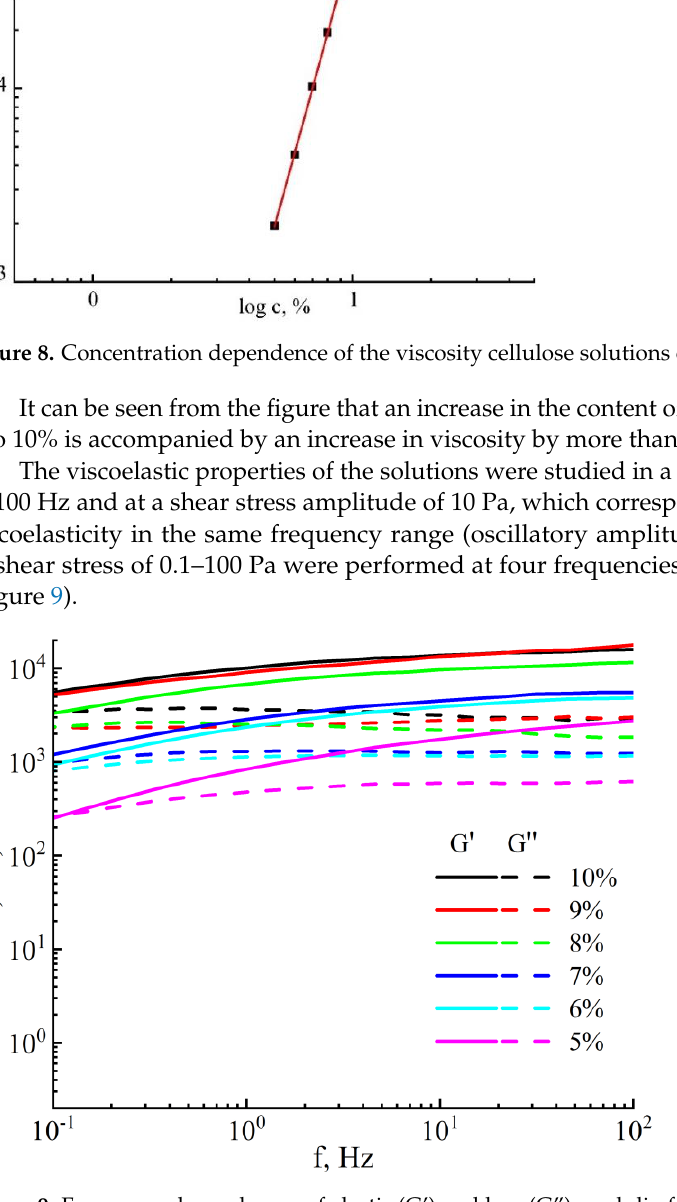
Figure 9. Frequency dependences of elastic (G ’ ) and loss (G ’’ ) moduli of systems based on flax noils cellulose and NMMO. The concentration of solutions is indicated on the graph.